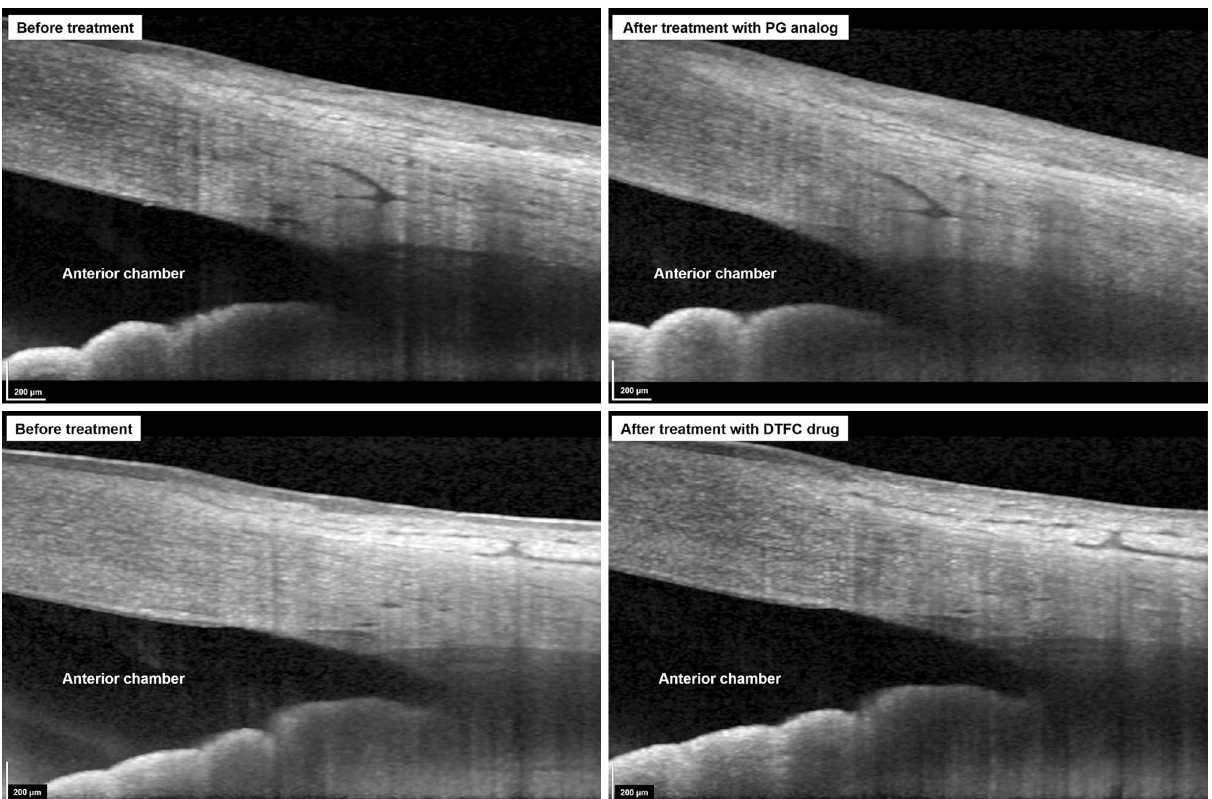
Figure 1. Enhanced depth imaging optical coherence tomography B-scans before (Left) and after (Right) administration of topical intraocular pressure-lowering agents. (Top) Trabecular meshwork thickness increase and Schlemm’s canal area reduction are observed after usage of prostaglandin analog for 3 months. (Bottom) The Schlemm’s canal area did not show significant changes after usage of dorzolamide/timolol fixed combination (DTFC)